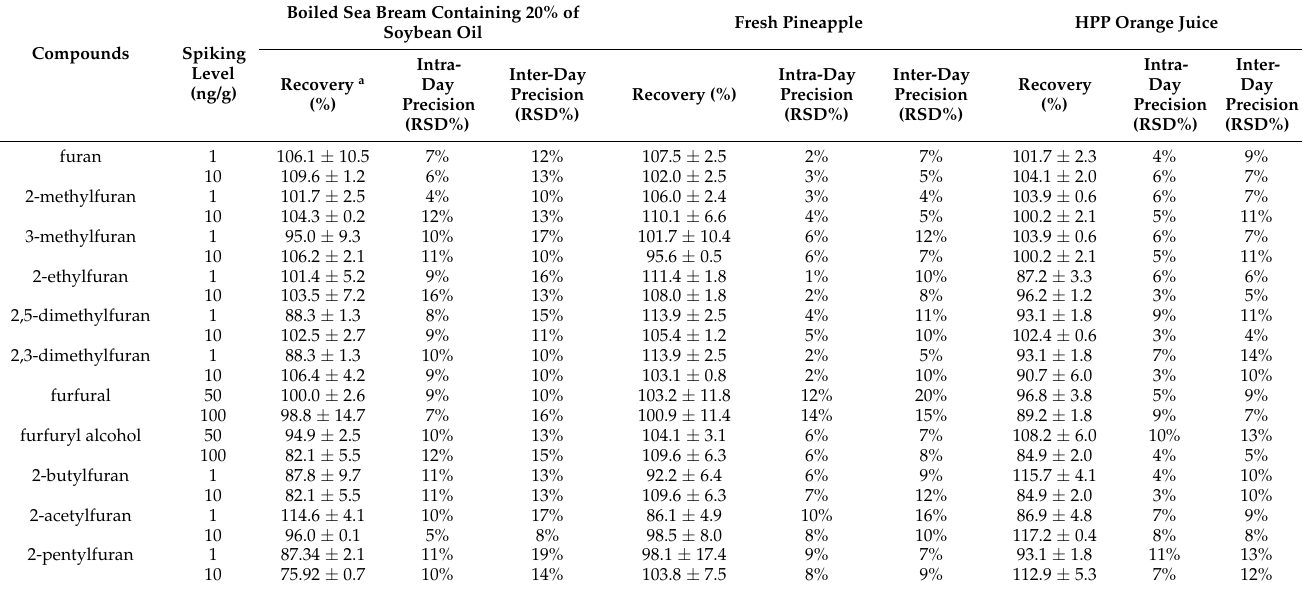
Table 2. Recovery and precision of furan and its derivatives in different food matrix detected by